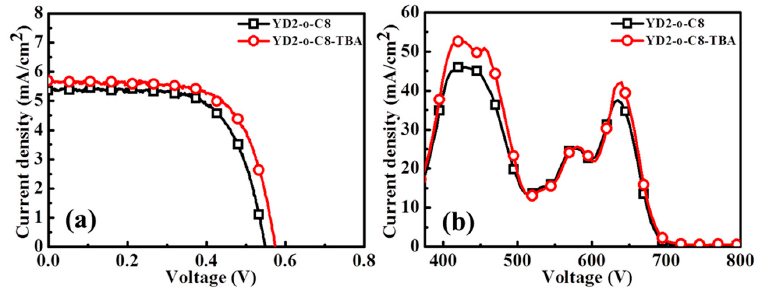
Figure 5. ( a ) J–V curves and ( b ) IPCE spectra of YD2-o-C8-sensitized and YD2-o-C8-TBA-sensitized ZnO DSSCs.